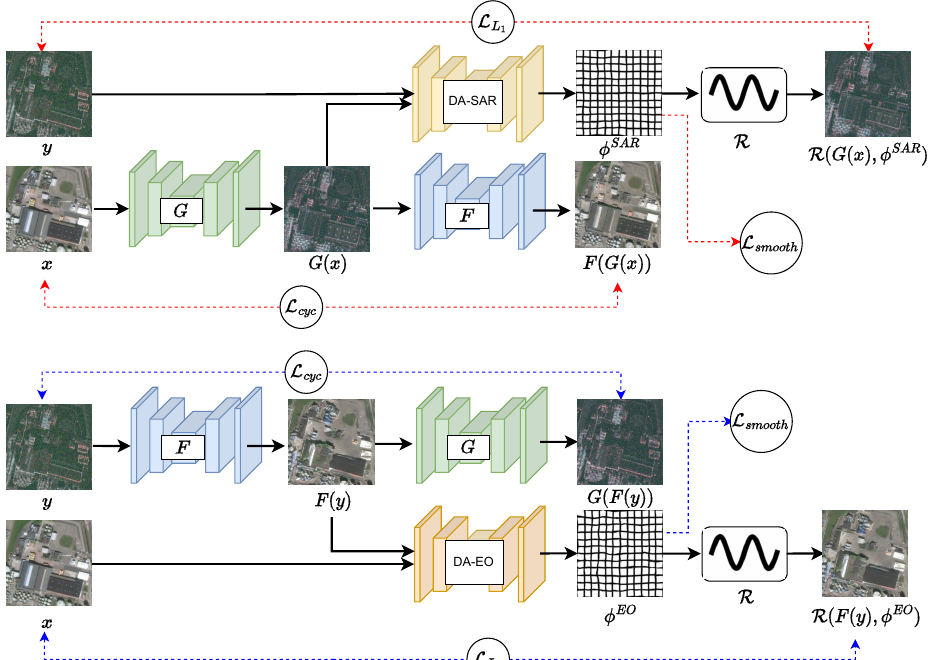
Figure 7. Training framework of our proposed